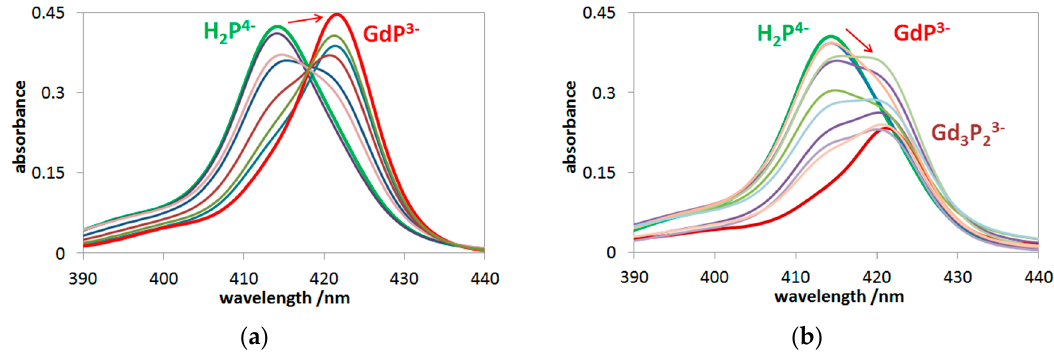
Figure 2. Spectrophotometric titration: ( a ) 1.3 × 10 − 6 M H 2 P 4 − and 0–9.2 × 10 − 4 M Gd(III), 0.01 M acetate and ( b ) 1.0 × 10 − 6 M H 2 P 4 − and 0–1 × 10 − 3 M Gd(III), 0.01 M perchlorate.